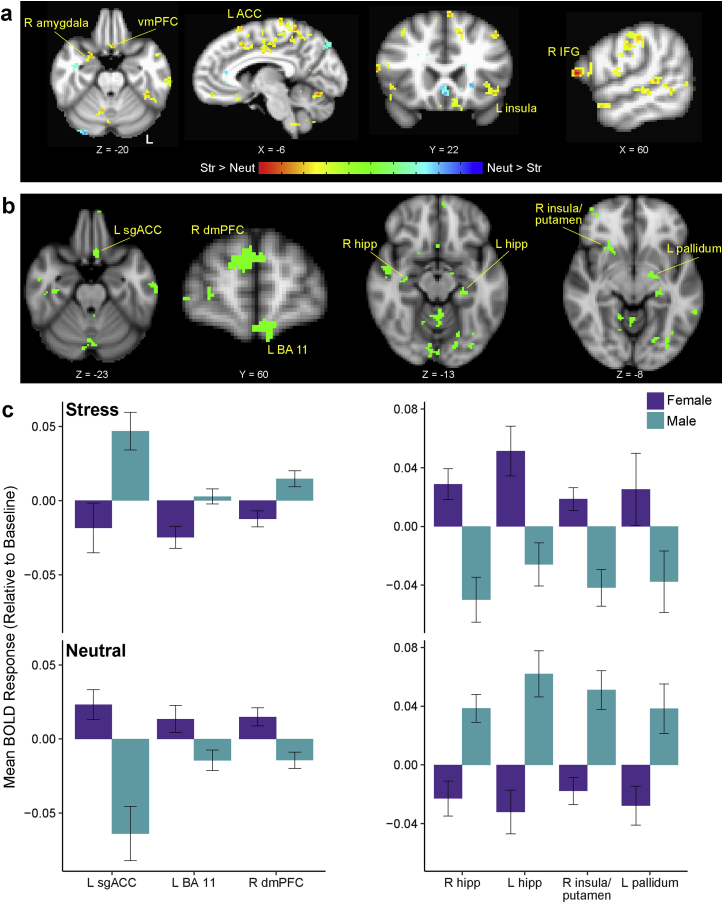
Responses to sustained stressor exposure: general and sex-specific. (a) Regions showing overall main effect of Condition (Stress vs Neutral). (b) Regions showing significant Condition (Stress vs Neutral) by Sex (Female vs Male) interaction. (c) Mean BOLD responses for male and female participants within clusters shown in (b) in each condition. Error bars = ± 1 SE. Conditions: Neut = Neutral, Str = Stress. Regions: ACC = anterior cingulate cortex; IFG = inferior frontal gyrus; vmPFC = ventromedial prefrontal cortex; sgACC = subgenual anterior cingulate cortex; dmPFC = dorsomedial prefrontal cortex. All brain images thresholded at voxelwise p < .01, cluster-corrected α = 0.05.